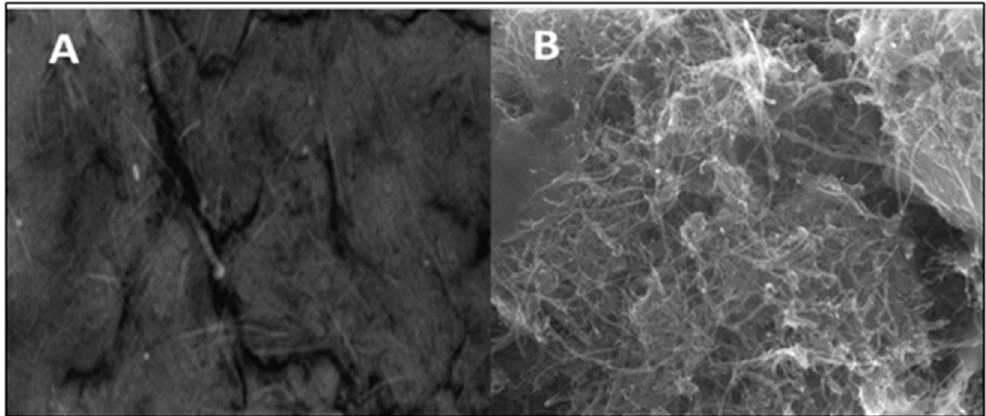
Figure 1. FESEM images of the ( A ) (MWCNT/MO) electrode, and ( B ) (MWCNT/IL/MO) electrode. Magnification: 40,000×.